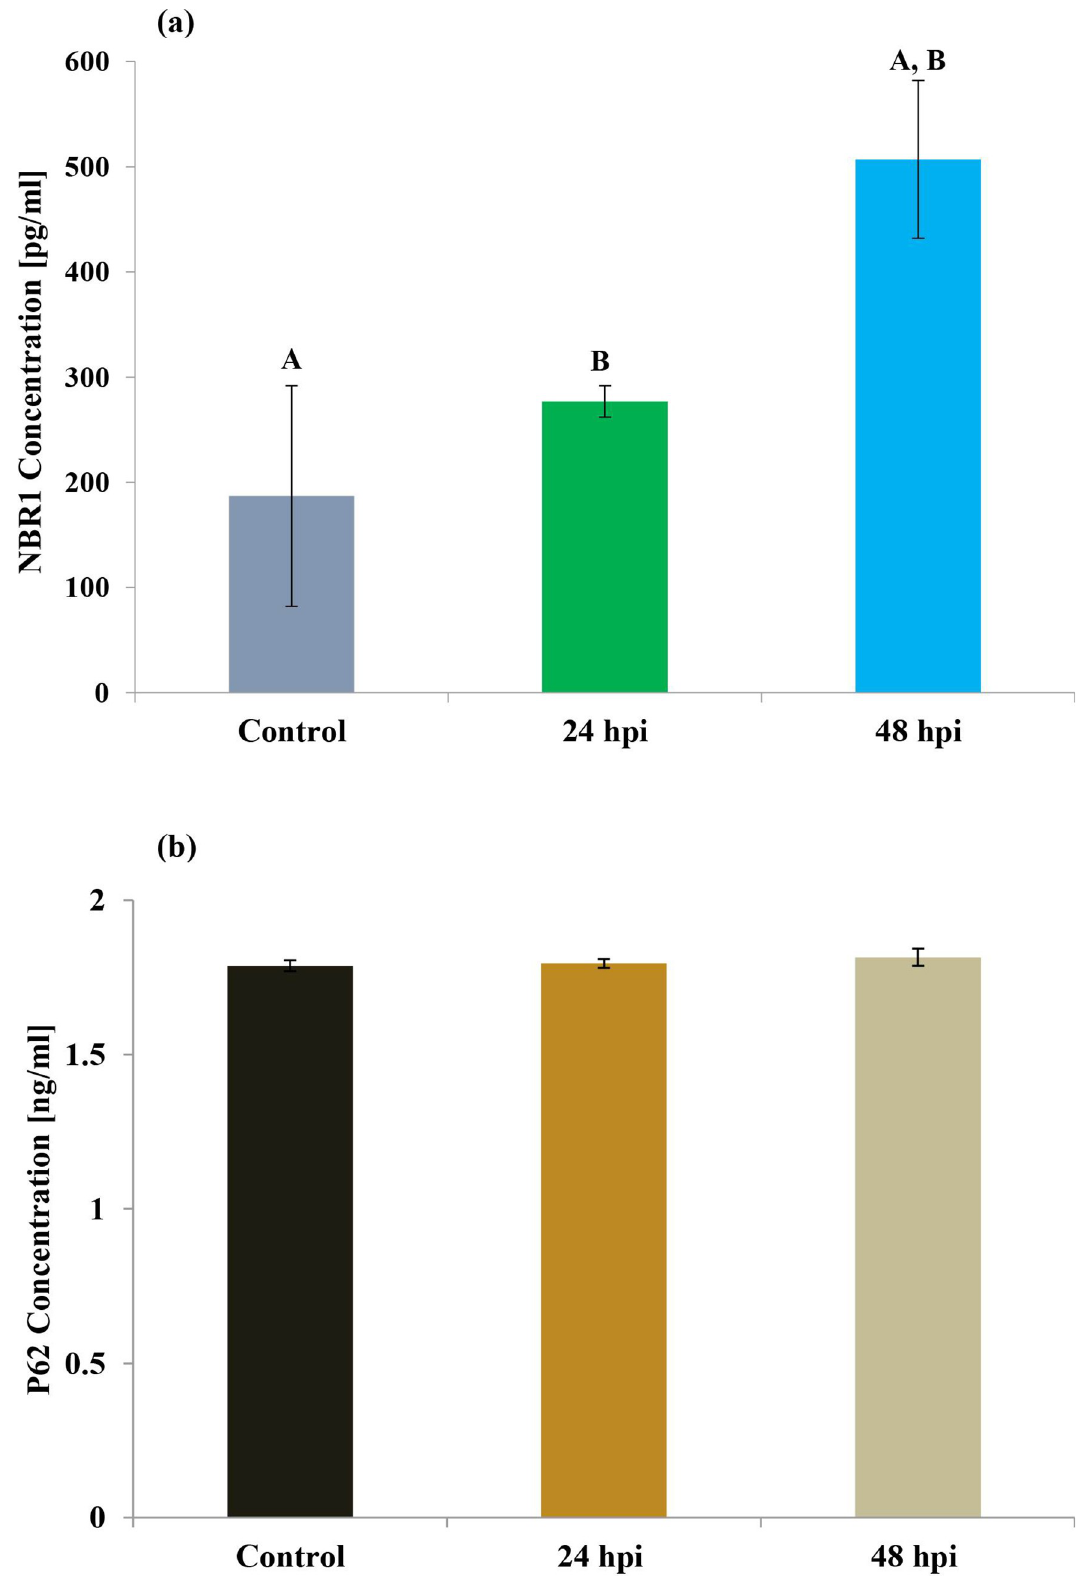
Fig 8. Determination of the level of NBR 1 and p62 protein in hemolymph of Galleria mellonella larvae. https://doi.org/10.1371/journal.pone.0228407.g008 PLOS ONE | https://doi.org/10.1371/journal.pone.0228407 February 3,